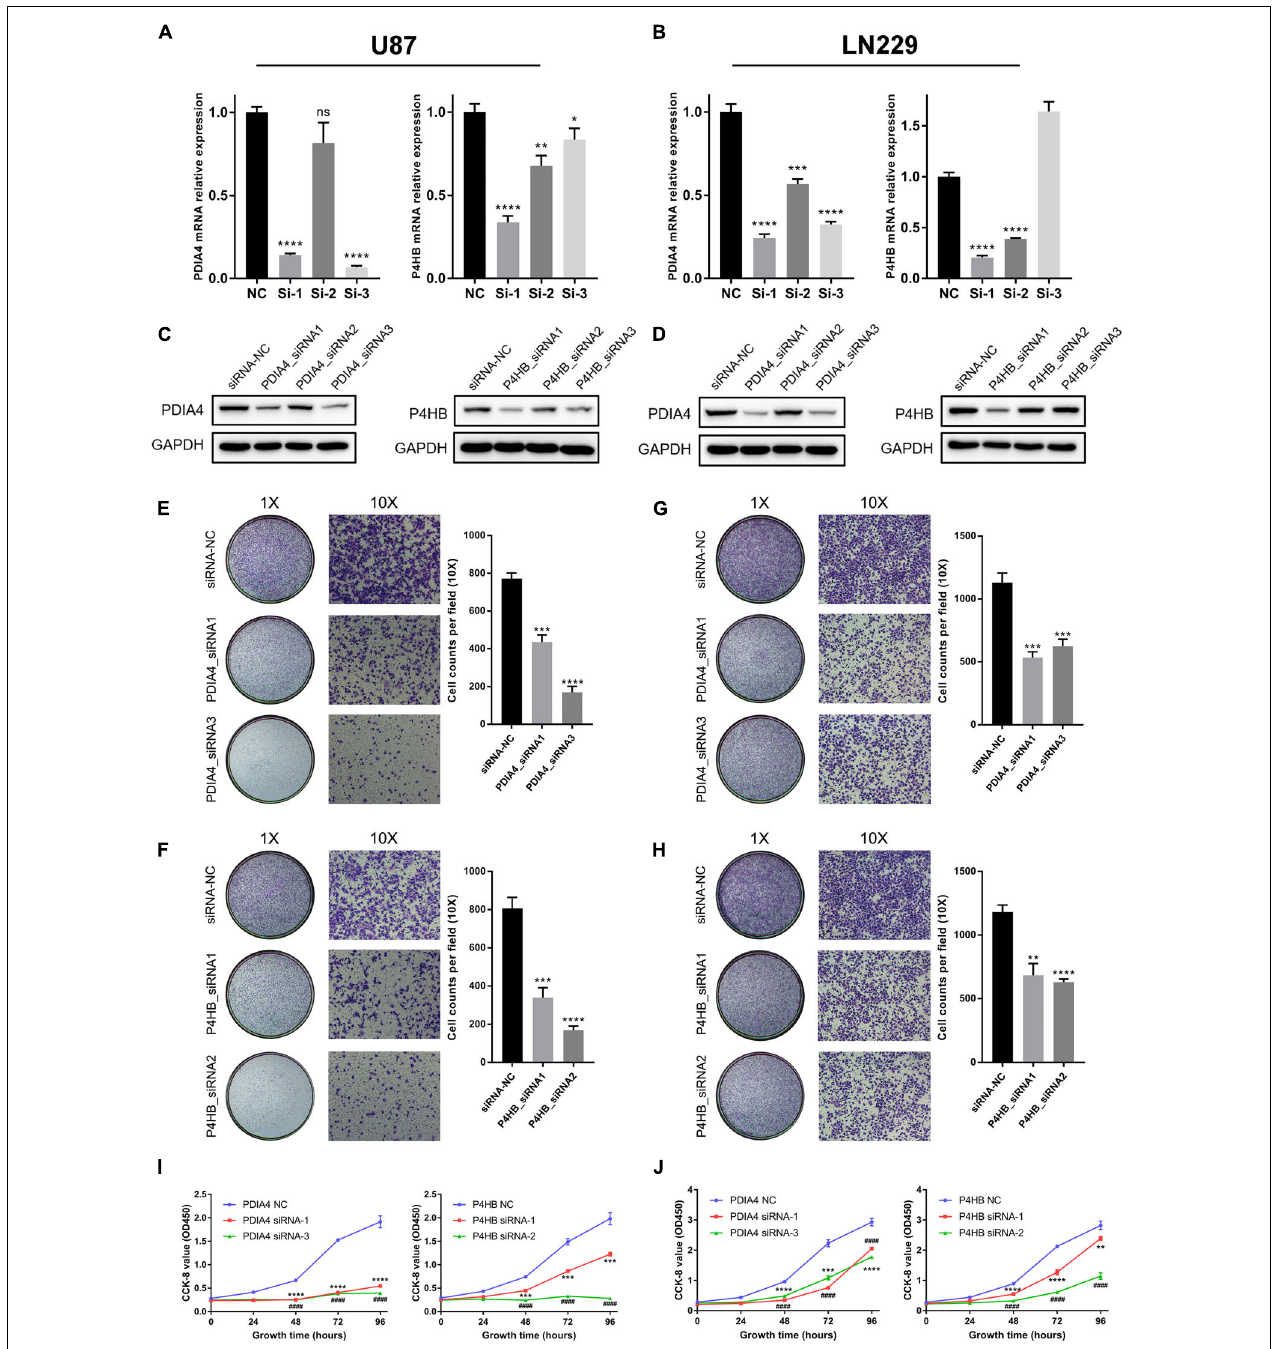
FIGURE 7 | ER stress activation promotes migration and proliferative capacity of glioma cell lines in vitro . (A,B) The real-time quantitative PCR (qPCR) assay of PDIA4 and P4HB mRNA expression in LN229 and U87 cell lines after applying specific siRNA and negative control. (C,D) The western blot analysis of PDIA4 and P4HB protein expression in LN229 (C) and U87 (D) cell lines after applying specific siRNA and negative control. (E–H) Transwell migration assay of LN229 (E,F) and U87 (G,H) cell lines treated with specific siRNA and negative control. (I,J) CCK-8 assay displaying proliferation of LN229 (I) and U87 (J) cell lines treated with specific siRNA and negative control. * p < 0.05, ** p < 0.01, *** p < 0.001, **** p <